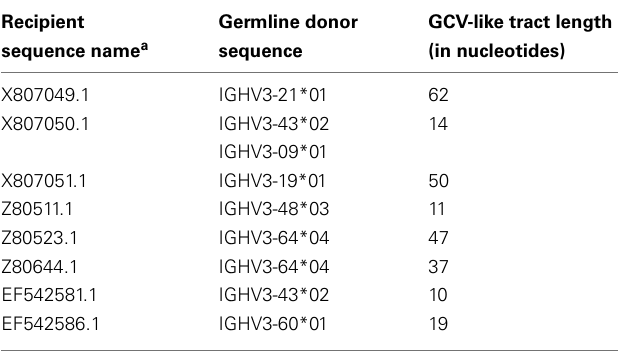
Table 3 | Characteristics of GCV-like tracts superimposed by SHM (identified by visual inspection of alignments).